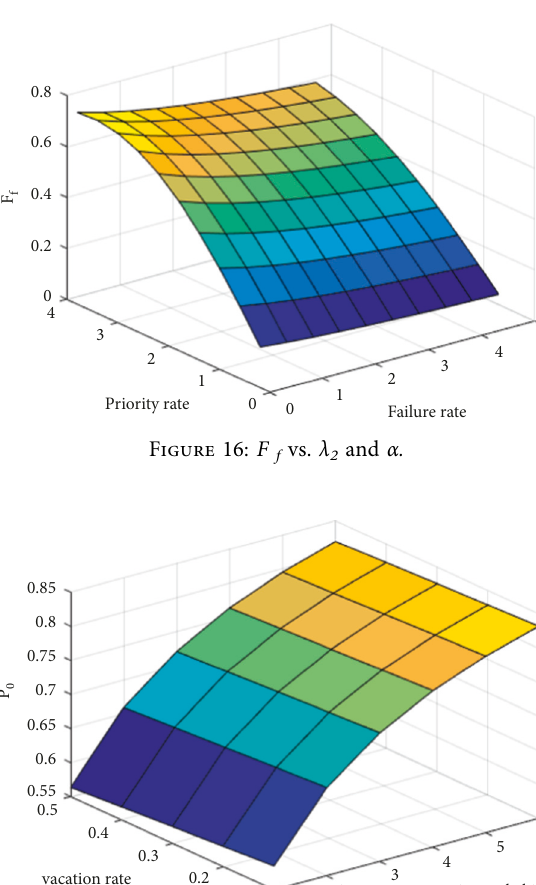
Figure 17: P 0 vs. (r) and θ.